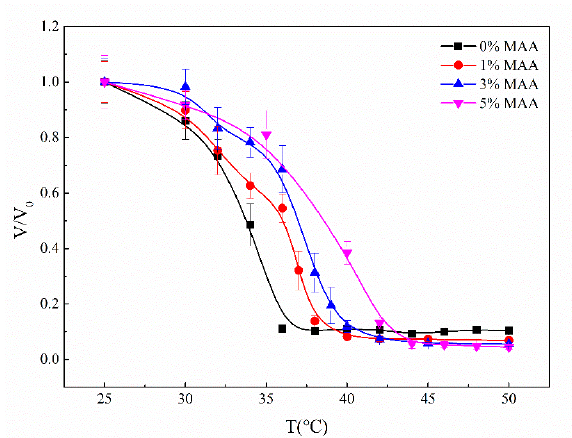
Figure 4. Effect of temperature on the volume ratio of solid P(NIPA- co -MAA) hydrogel microspheres with different MAA molar percentages.